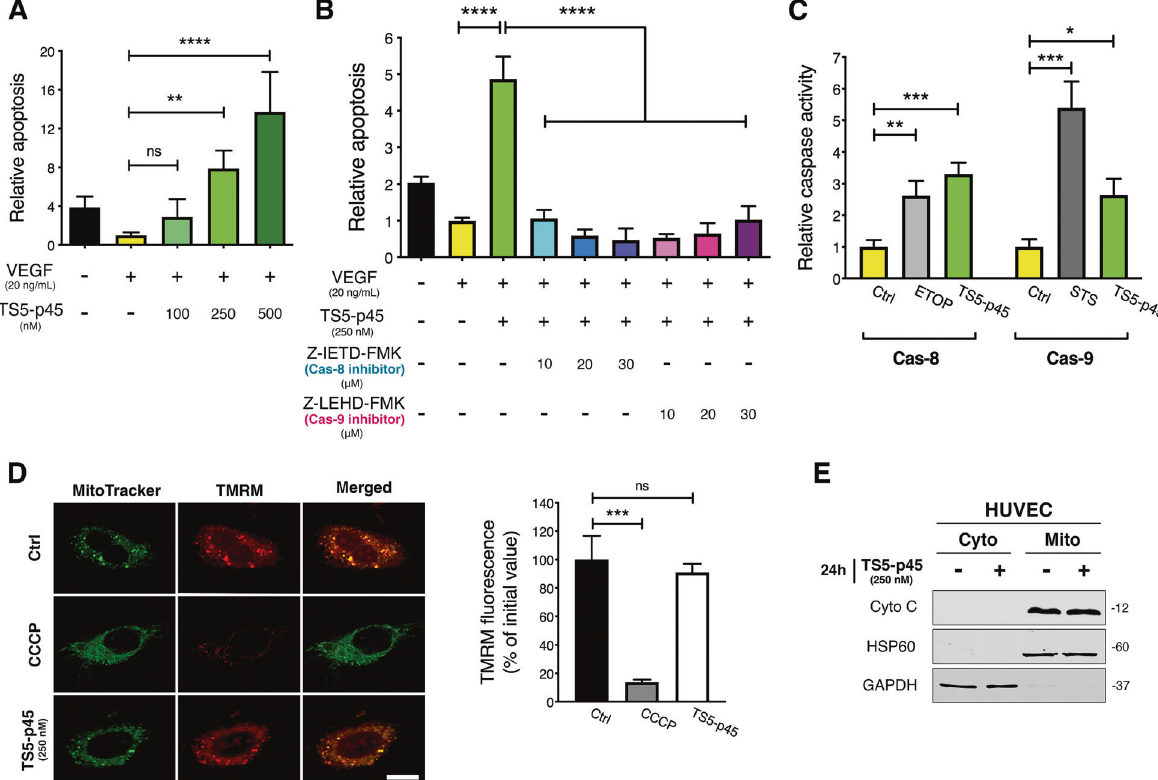
Fig. 1 TS5-p45 induces EC apoptosis through both Cas-8 and Cas-9 without affecting mitochondrial integrity. A TS5-p45 induces EC apoptosis in a dose-dependent manner. Apoptotic activity in ECs was measured at 24 h post-TS5-p45 treatment. Data shown are mean ± SD from three independent experiments in triplicates. B Cas-8 and Cas-9 inhibitors both impaired the TS5-p45-induced apoptosis. HUVECs pre- treated with Cas-8 inhibitor (Z-IETD-FMK) and Cas-9 inhibitor (Z-LEHD-FMK) were treated with TS5-p45, and apoptosis was measured at 24 h post-TS5-p45 treatment. Data shown are mean ± SD from three independent experiments in triplicates. C TS5-p45 induces both Cas-8 and Cas-9 activities. HUVEC lysates obtained at 24 h post-TS5-p45 treatment were used to determine respective caspase activities. ETOP- and STS- treated lysates were used as positive controls for Cas-8 and Cas-9 activities, respectively. Data shown are mean ± SD from three independent experiments in duplicates. D ψ mito is not disturbed by TS5-p45. ψ mito is indicated by TMRM staining, and MitoTracker green is used to label mitochondria. Scale bar represents 10 μ m. TMRM signal from HUVECs at 24 h post-TS5-p45 treatment was compared to TMRM signal at 0 h. CCCP treatment was used as a control to disrupt ψ mito . Data shown are mean ± SD from three independent experiments in triplicates. E TS5- p45 does not induce Cyto C release into the cytosol. Cyto: cytosol, Mito: mitochondria. Molecular weight (kDa) is indicated on the right side of the WB. Statistical analysis was performed by one-way ANOVA. ns, not signi fi cant; * p < 0.05; ** p < 0.01; *** p < 0.001; **** p < according to the manufacturer ’ s protocol. WB antibodies used in these experiments were anti-FLAG (Sigma-Aldrich, F1804) and anti-His (Abcam, ab9108).